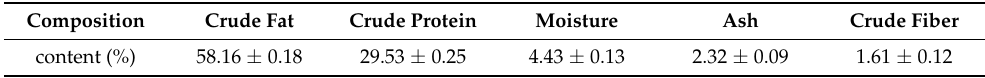
Table 1. The chemical composition of the X. sorbifolia